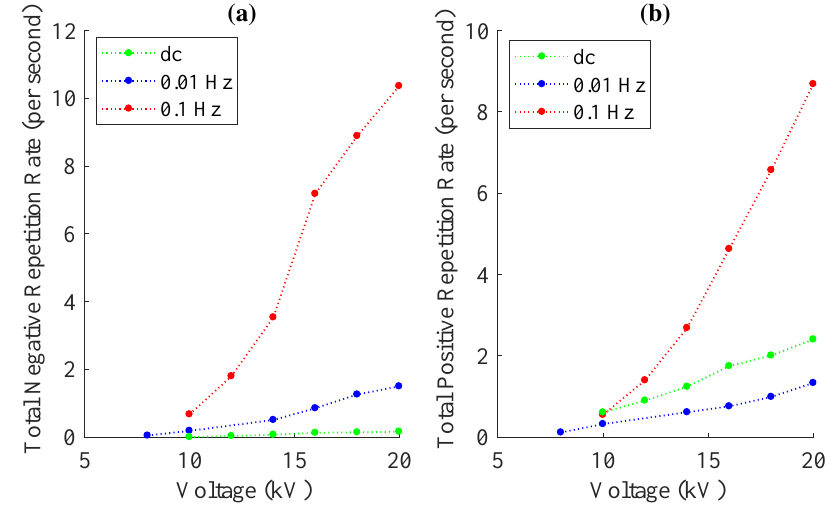
Figure 10. Voltage dependence of total PD repetition rate for ( a ) negative rate; ( b ) positive